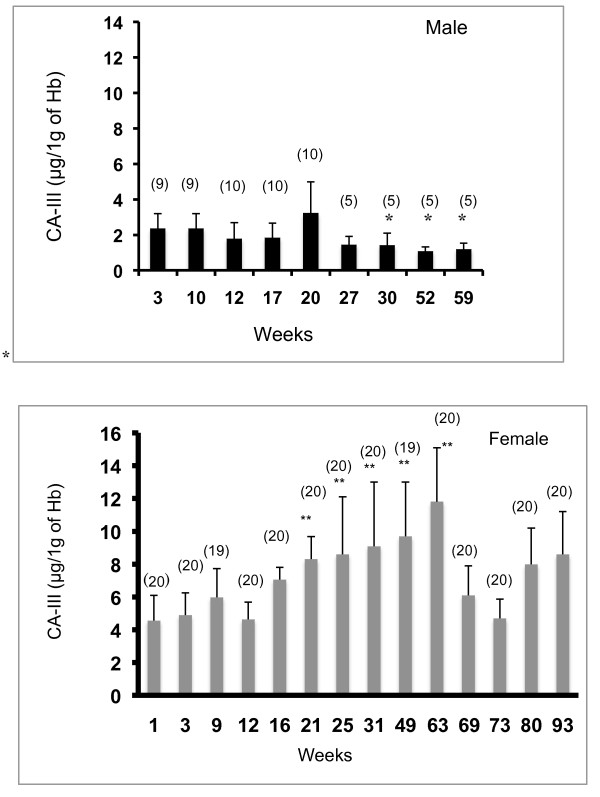
Developmental changes in erythrocyte CA-III levels in male and female WL-chickens. Means and standard deviations of erythrocyte CA-III concentrations (μg/g of Hb) in male (top) and female (bottom) WL-chickens. The number of samples is shown on the column. The CA-III level in erythrocytes of male WL-chickens did not change significantly from 3 to 27 weeks of age. The mean levels of CA-III in male WL-chicken erythrocytes at 30, 52, and 59 weeks of age were less than that at 20 weeks of age (p < 0.05). The levels of CA-III in female chicken erythrocytes (1 week old) did not change until 16 weeks of age. From 21 weeks of age, the CA-III levels in female WL-chickens increased significantly at 25, 31, 49, and 63 weeks of age. The level of CA-III in hemolysate from female WL-chickens peaked at 63 weeks of age. The CA-III then decreased gradually until 73 weeks of age and increased again until 93 weeks of age. : *: p < 0.05, **: p < 0.01.